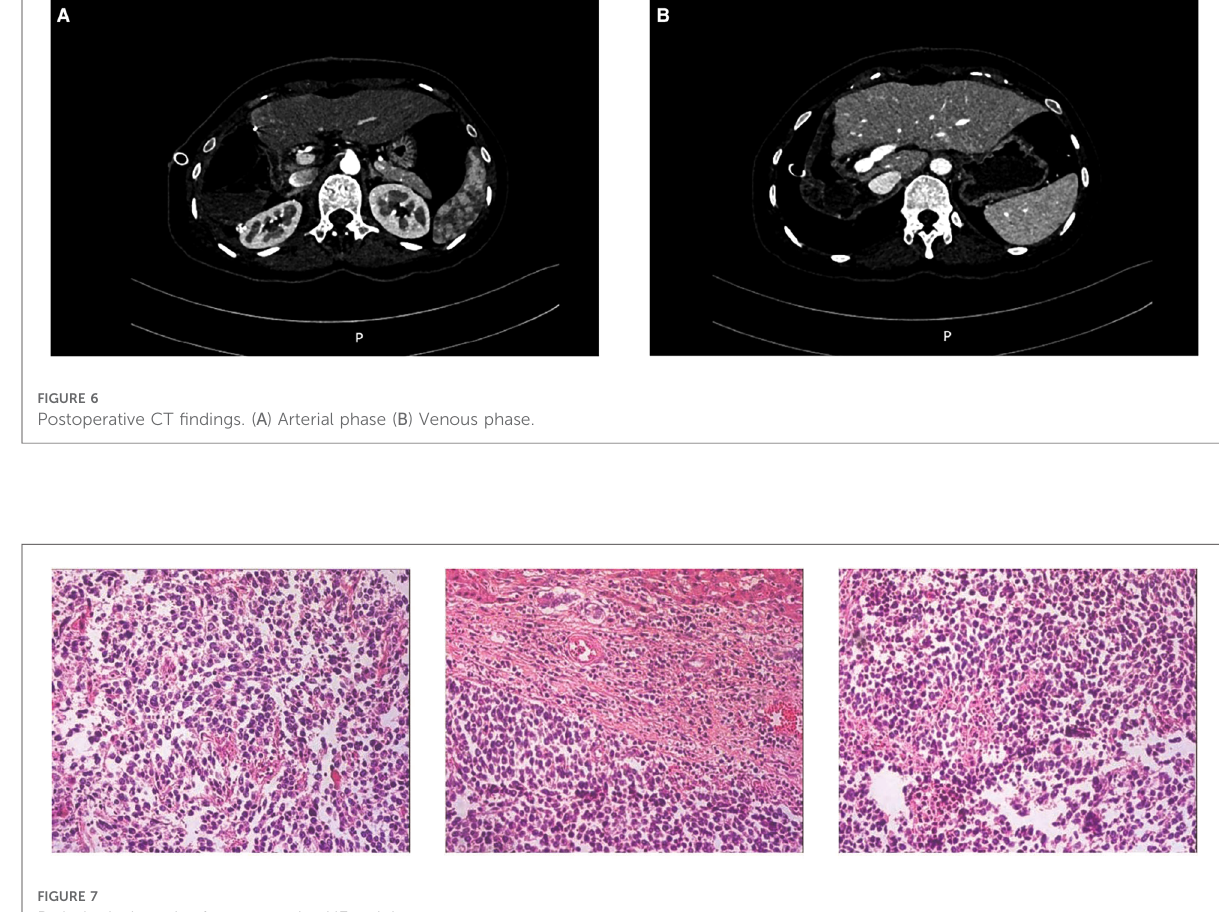
FIGURE 7 Pathological result of postoperative HE